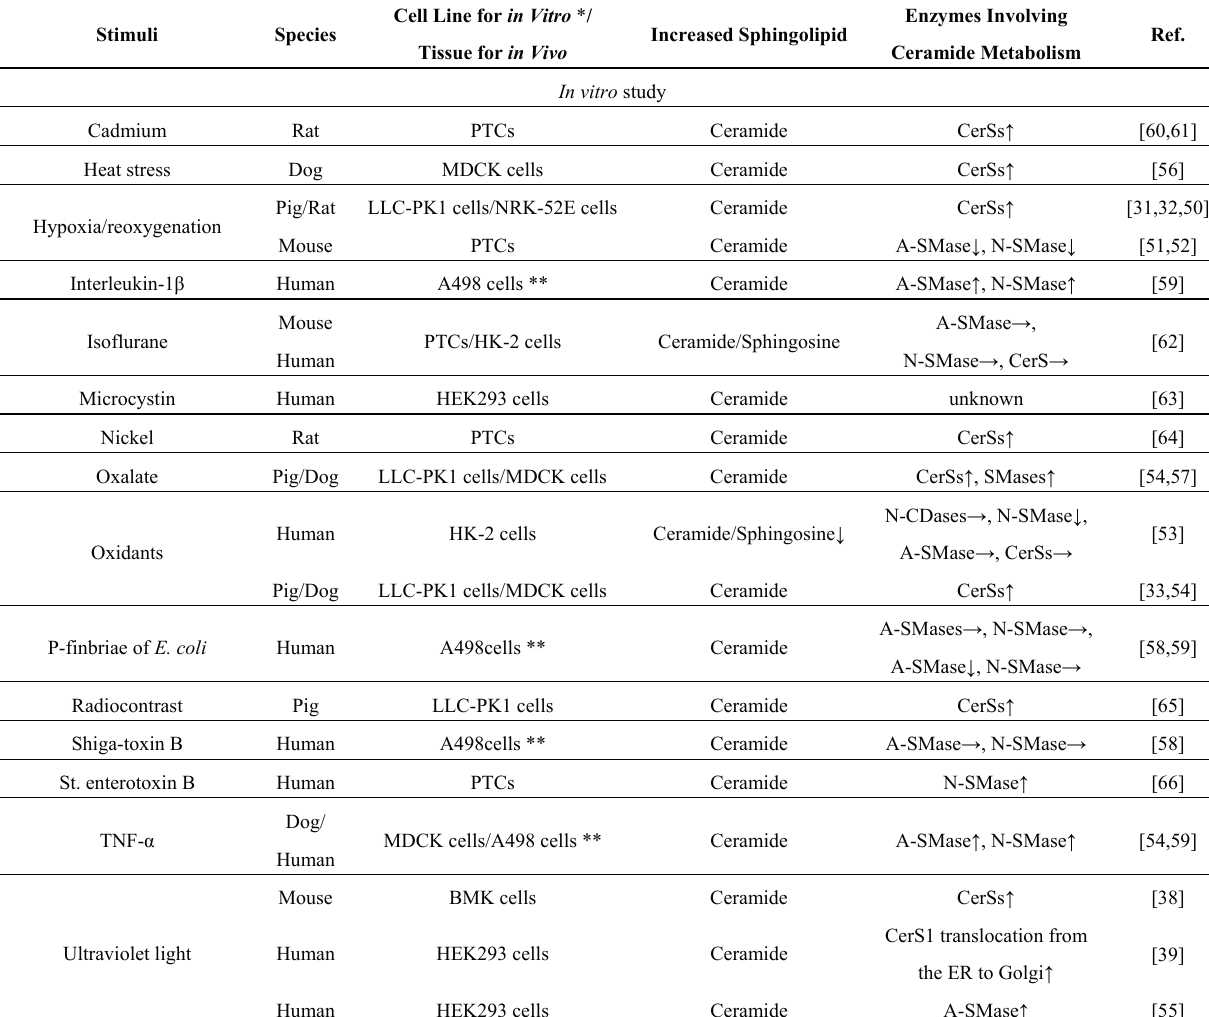
Table 1. Ceramide/sphingosine generation in renal tubular cells after exposure to various